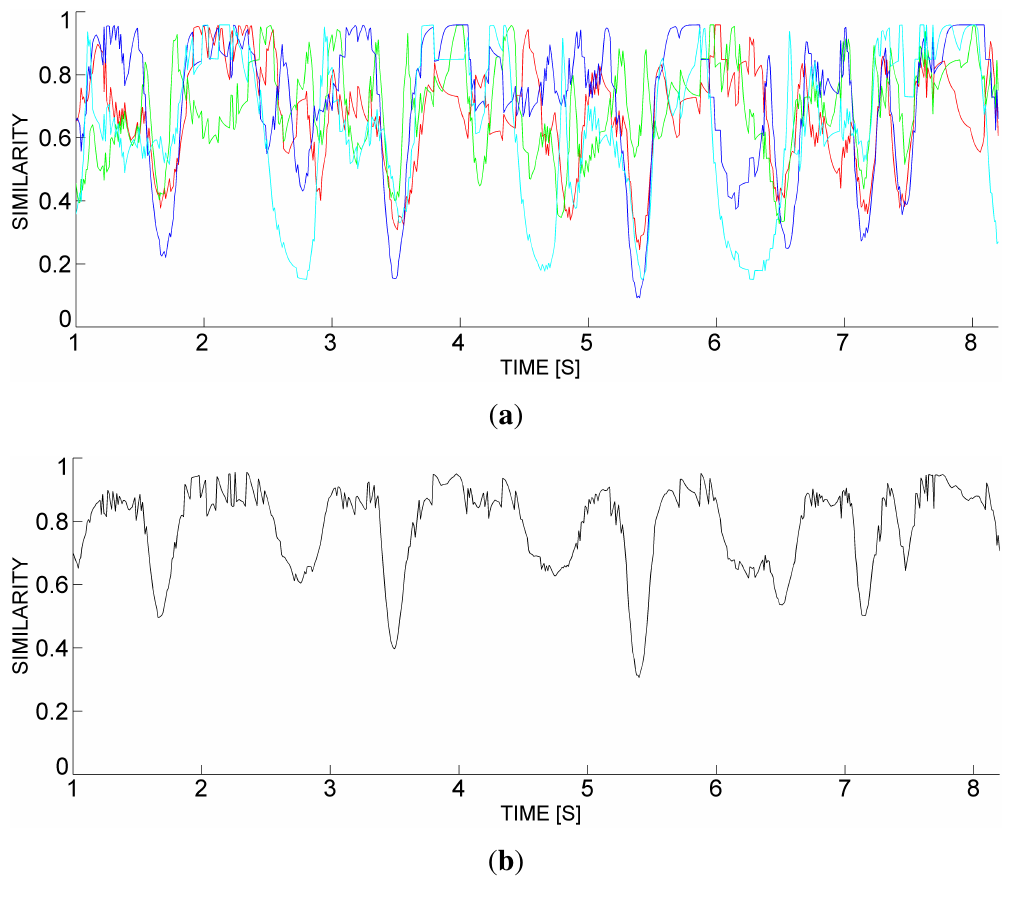
Figure 10. Similarity of the accumulated marks ( a ) and collective mark ( b ) with their references, in the pilot scenario